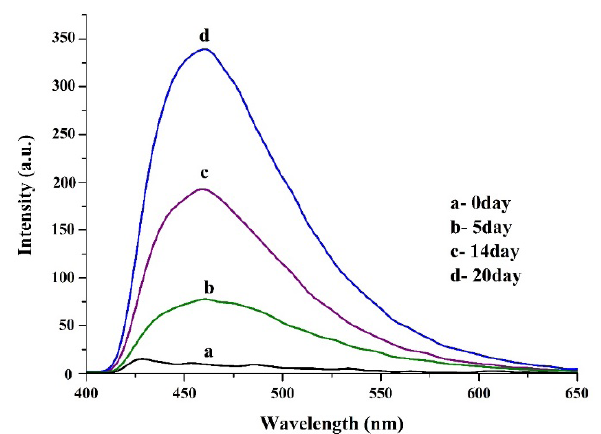
Figure 2: The fluorescence spectra of HSA incubated with glucose for different